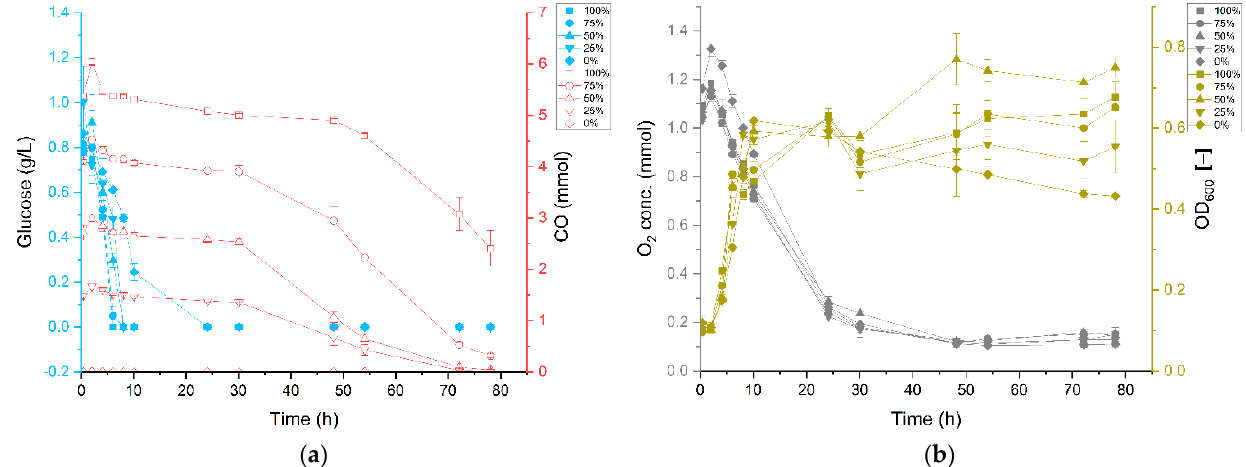
Figure 4. Growth of P. thermoglucosidasius DSM 6285 under different initial carbon monoxide atmospheres. ( a ) Concentrations of carbon monoxide (0, 25, 50, 75 and 100% CO) and glucose and ( b ) the corresponding OD 600 and O 2 concentrations over the duration of cultivation. Reported values represent means of triplicate experiments ± standard deviation. CO, glucose, OD 600 and O 2 are shown in red, blue, dark yellow and grey colours,